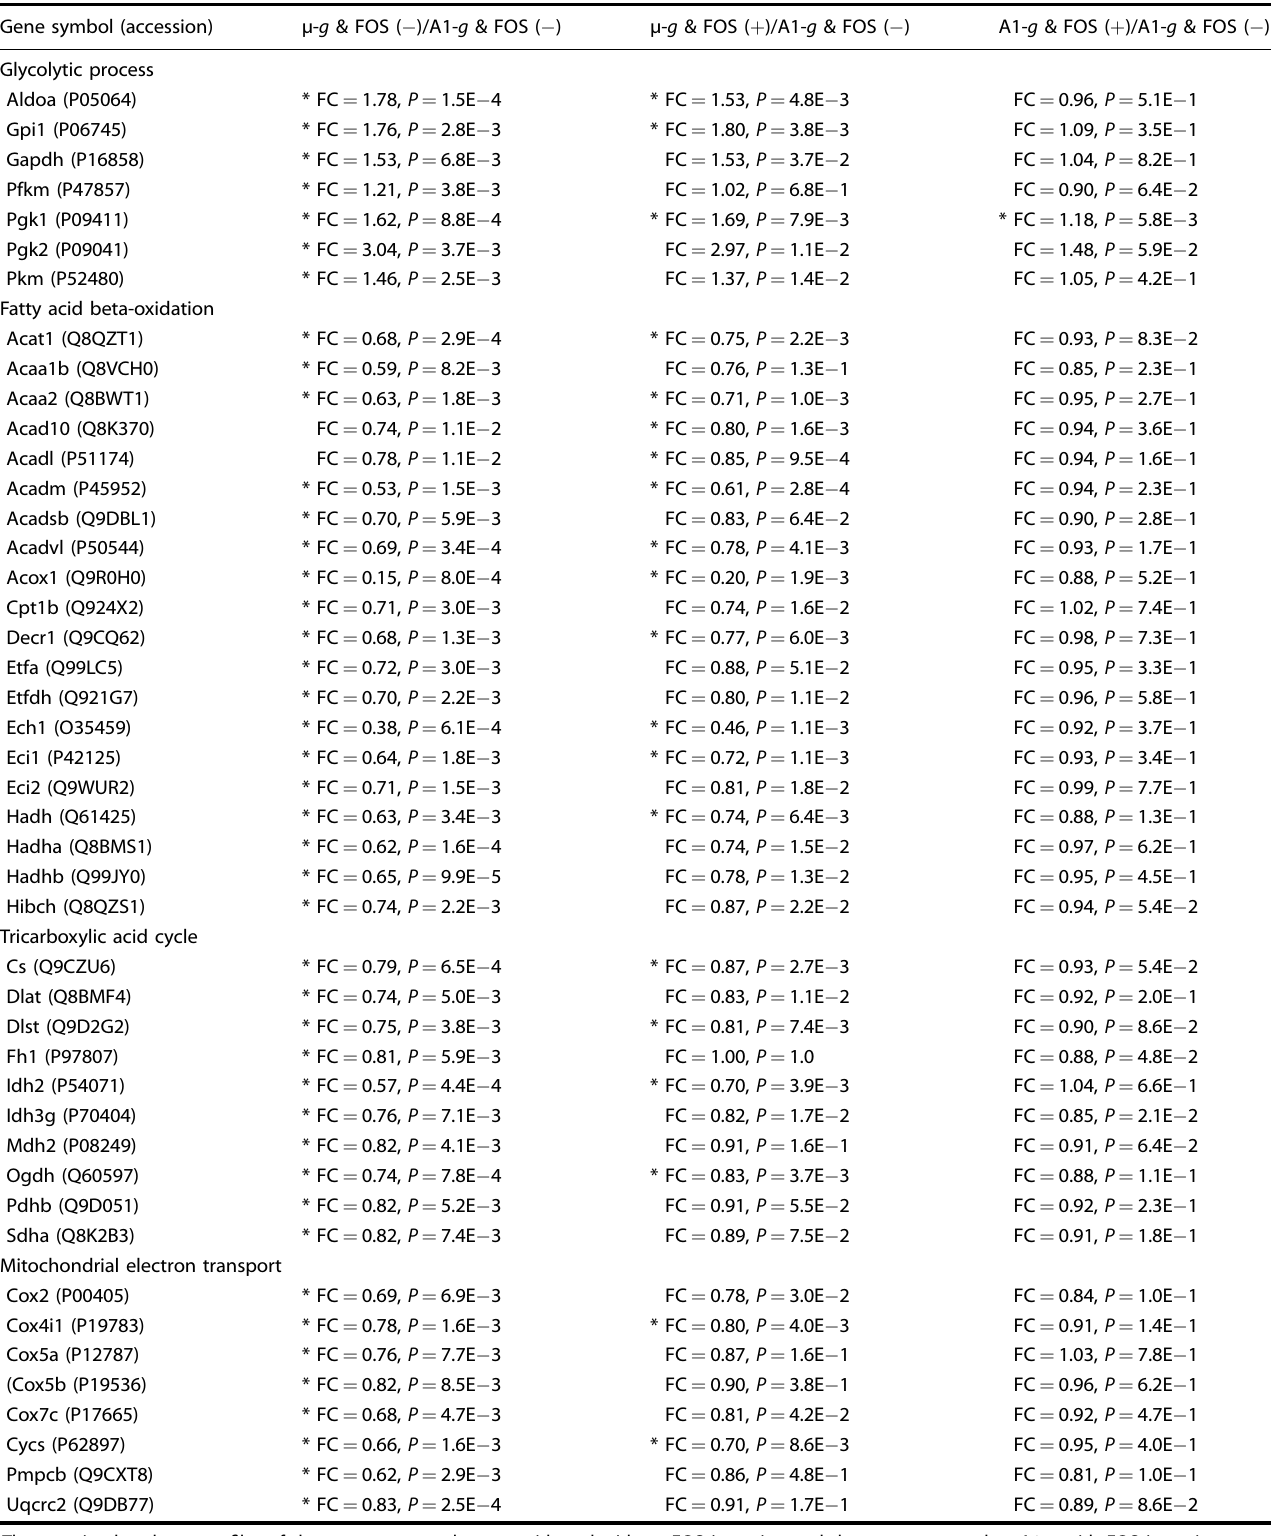
Table 1. Responses of soleus (Sol) muscle proteins involved in metabolic processes to microgravity (µ- g ) or arti fi cial 1- g (A1- g ) exposure and/or fructo-oligosaccharide (FOS)